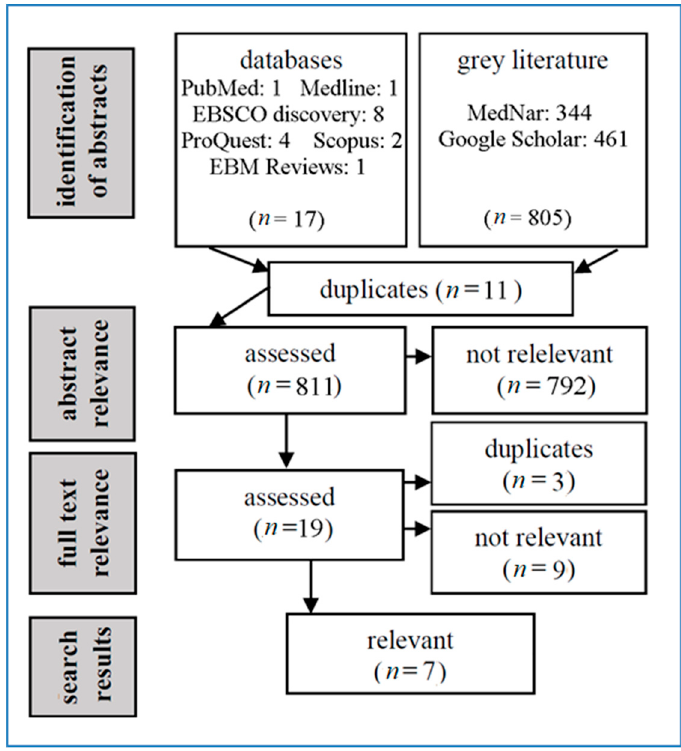
Figure 2. Flow diagram of the literature search (searches in databases with zero results are not listed in the flow diagram).